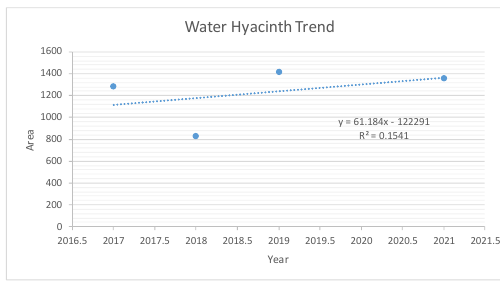
Figure 12: Water Hyacinth trend without 2020 outlier When the trend is analysed without the outlier, the rate of increase reduces four times thus depicting almost a constant area of coverage of water hyacinth in the Winum Gulf. However, the coverage of water hyacinth does not depict a direct correlation with the presence of undissolved minerals, nitrogen content and